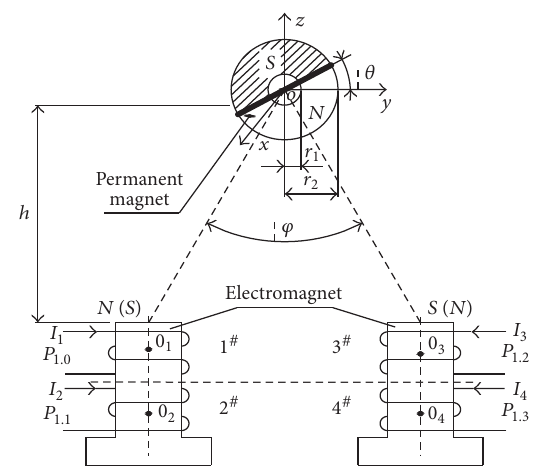
Figure 2: Schematic diagram of magnetic drive